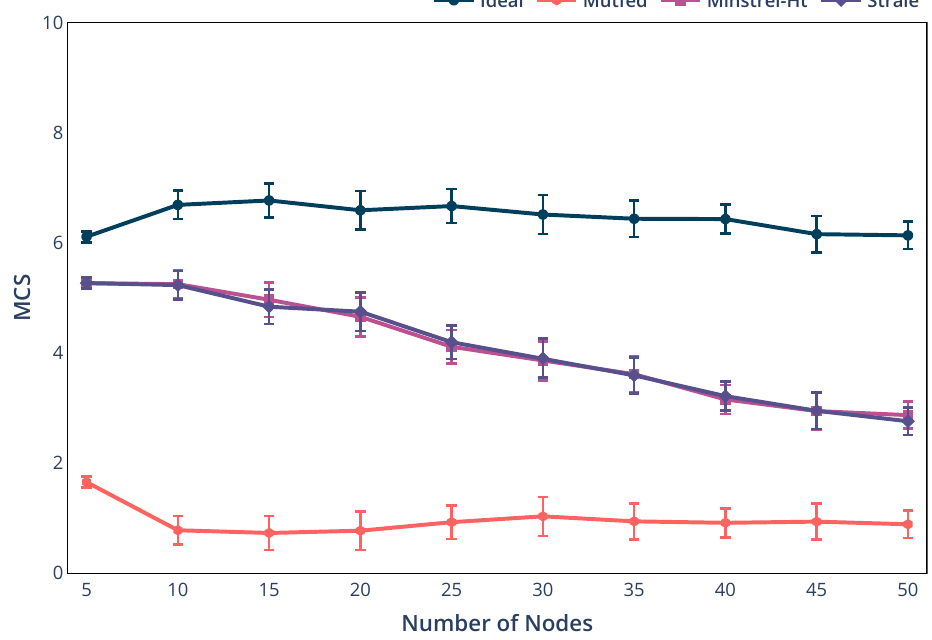
Figure 5. Mean value of the modulation and coding schemes (MCS) used by the